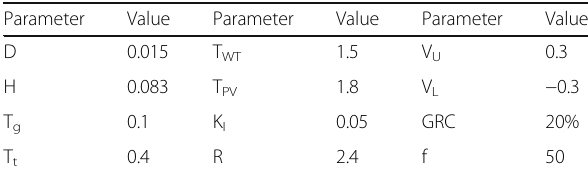
Table 1 Islanded microgrid parameters